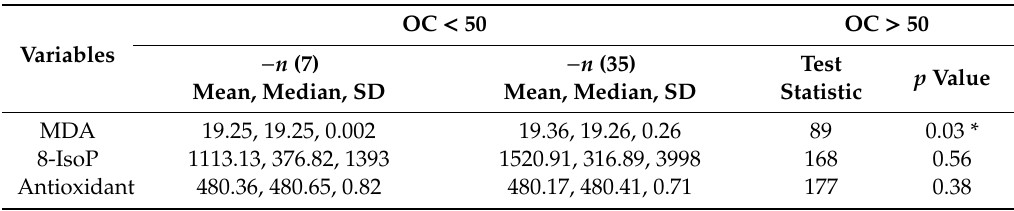
Table 5. Levels of oxidative stress biomarkers in participants with high and low OC (Wilcoxon–Mann–Whitney test). Table 3. Normality test (Shapiro–Wilk test) showing distribution of job stress indicators and oxidative stress biomarkers.